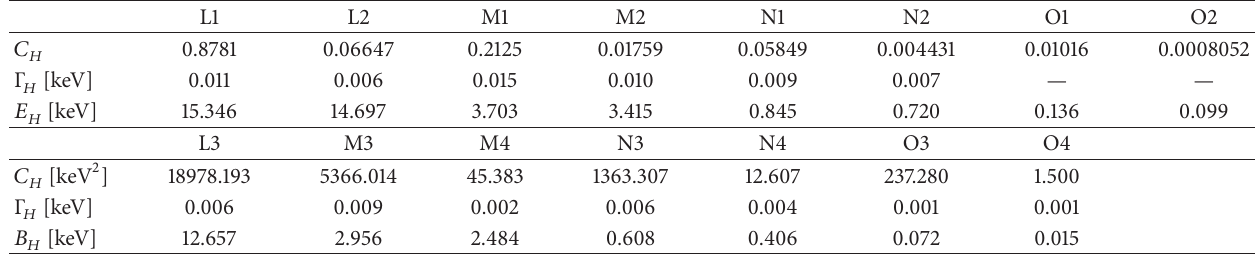
Table 2: Same as Table 1 (data from the same references) but for electron capture in Lead going to Thallium. The upper table summarizes the values of the relevant parameters for 𝑠 1/2 and 𝑝 1/2 atomic shells, while the lower table shows the values for 𝑝 3/2 and 𝑑 3/2 atomic shells. In the latter case, 𝐶 𝐻 includes an extra factor 𝑝 2 𝑒 . L1